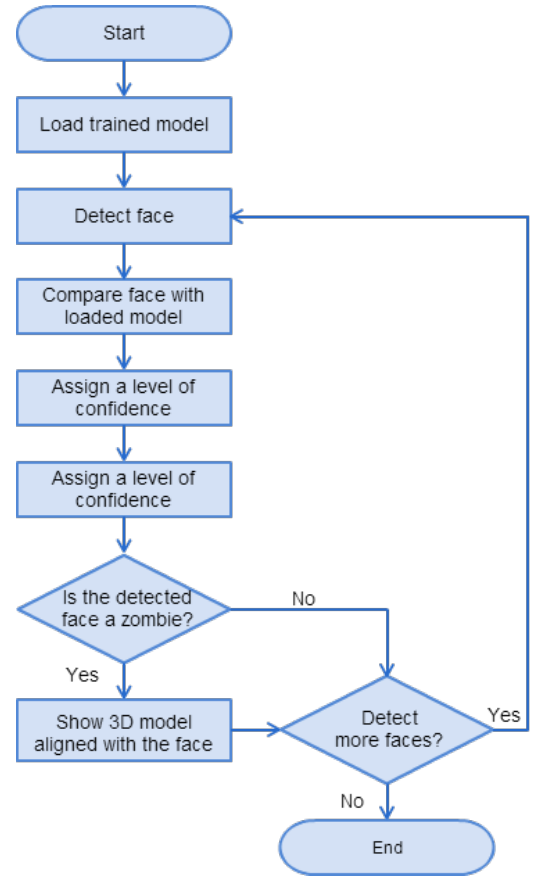
Figure 12: Face recognition process.